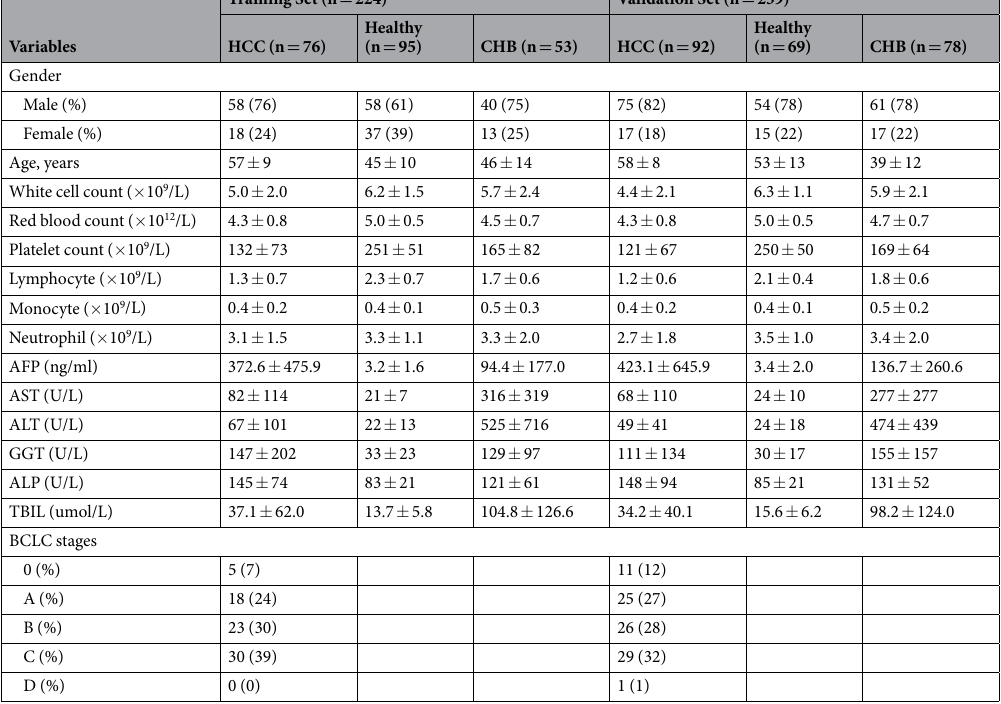
Table 1. Comparison of characteristics of patients with HCC, CHB and healthy control in training and validation sets. Values are expressed as mean ± SD. GGT, gamma-glutamyl transpeptidase; TBIL, total bilirubin.